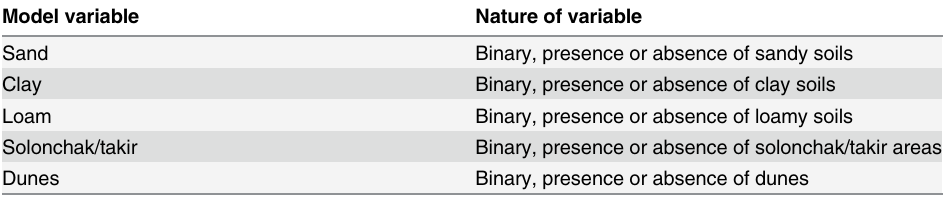
Table 1. Landscape factors used in models, built using landscape descriptors listed